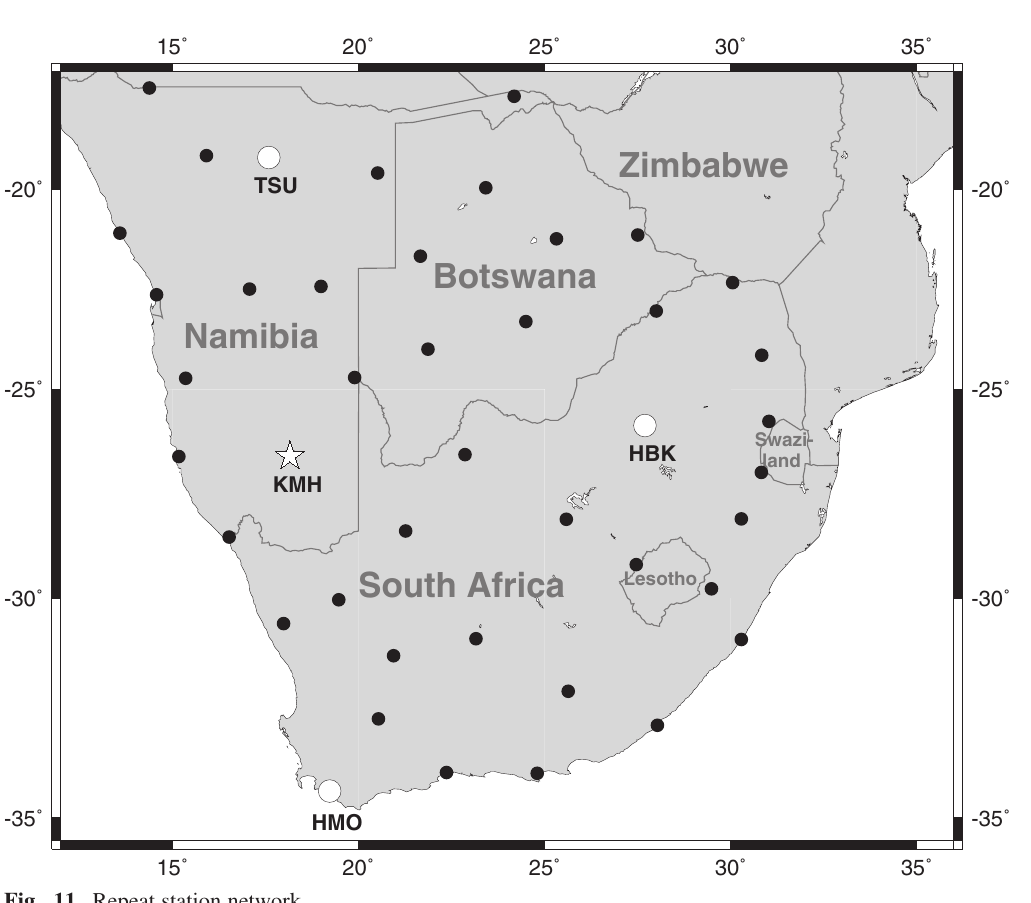
Fig. 11. Repeat station